Question: Compose a caption that would accompany this figure in a paper.
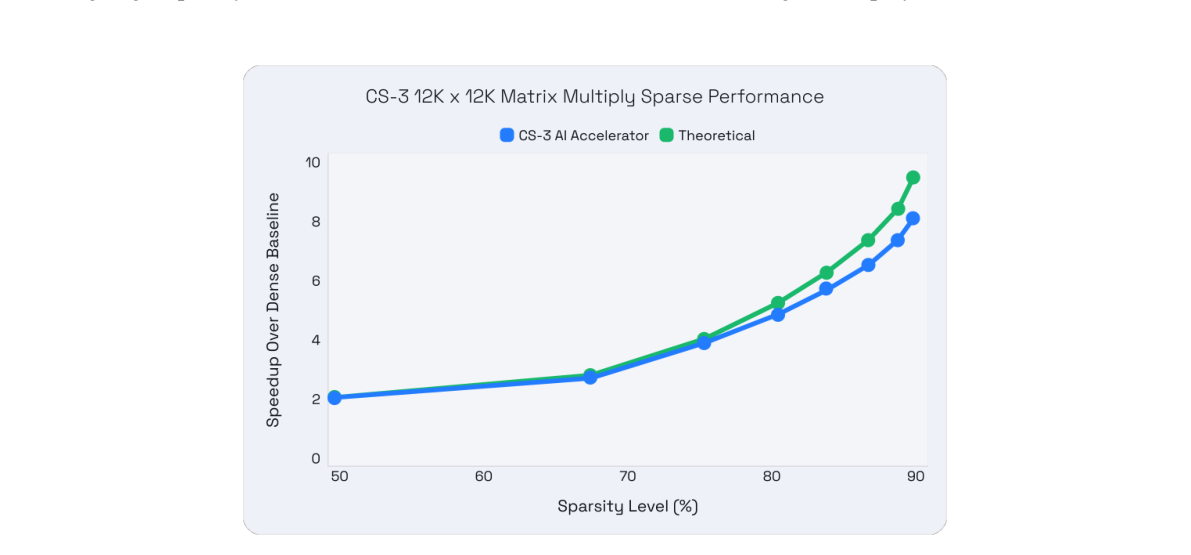
Answer: Compute performance for a 12K x 12K Matrix Multiply on Cerebras CS-3 AI accelerator comparing theoretical vs. realized performance in relation to sparsity.